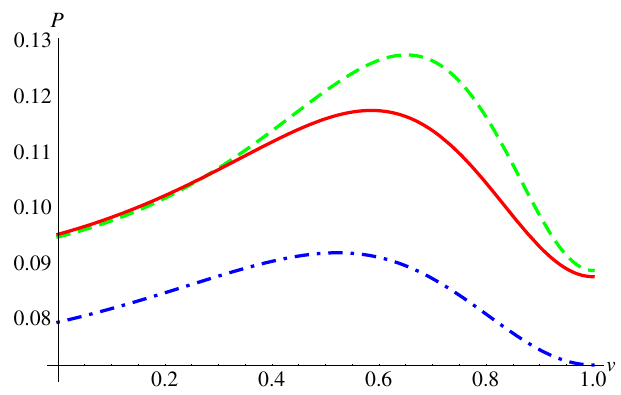
FIG. 12. EMP as a function of the ratio of bath tempera- tures for two topological anyons with ν = 0.8 (dashed, gray) and two distinguishable quantum particles (dot dashed, blue). The Curzon-Ahlborn efficiency (lower solid, red) and Carnot efficiency (upper solid, black) are given in comparison. Opera- tion is in the quantum regime corresponding to (cid:2) ω 2 / k B T c = 10. Parameters are α c = α h = γ = 1, and τ c = τ h =